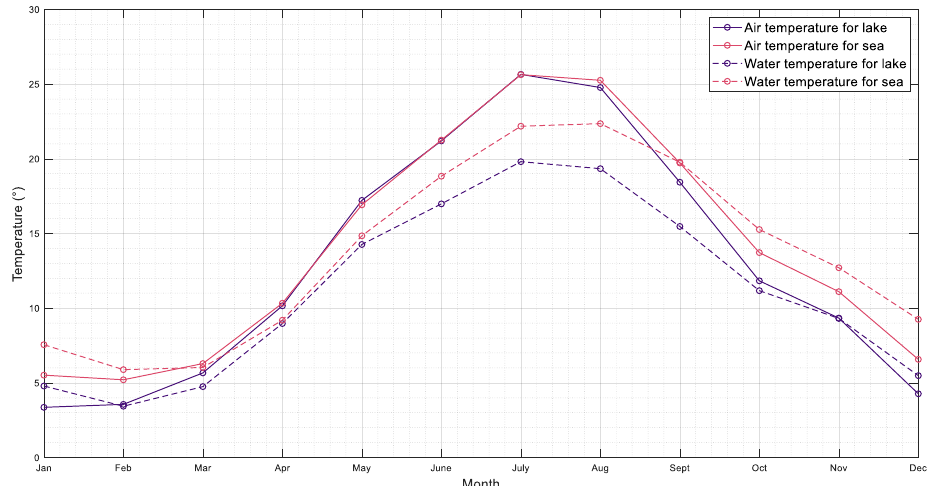
Figure 10. Average monthly temperature variations.